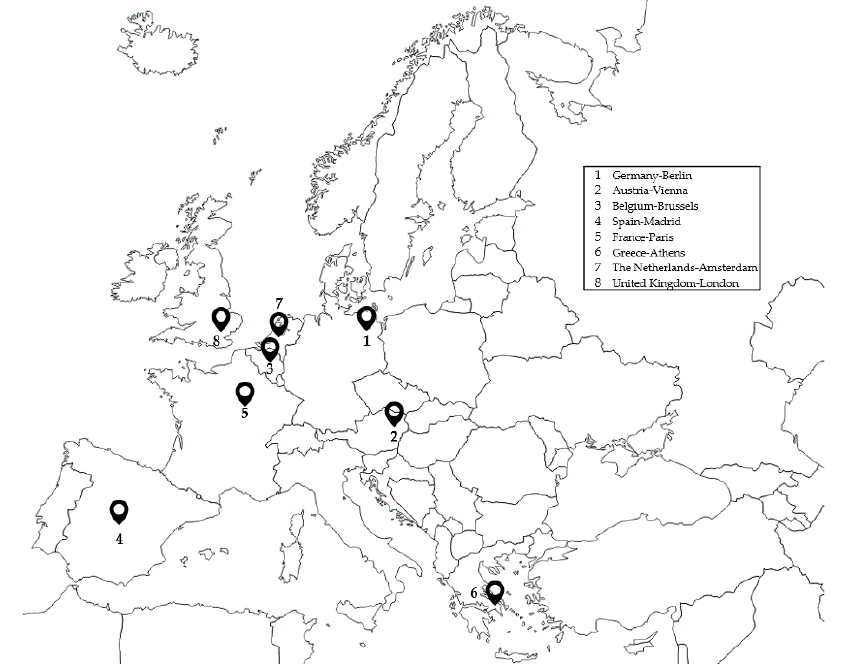
Figure 8. Selected airports.